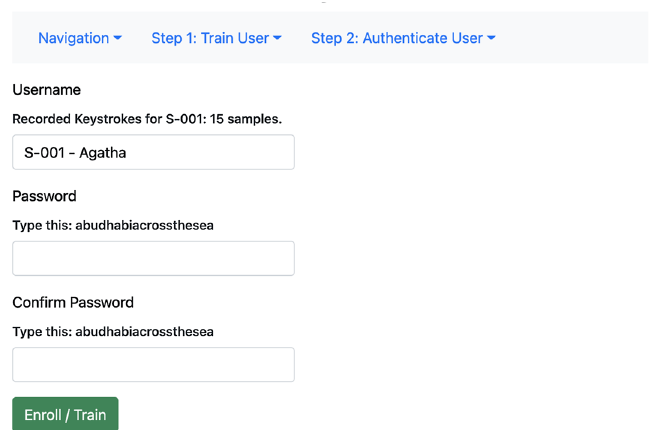
Fig. 15 KeyTrac recorder web application for attack simulation